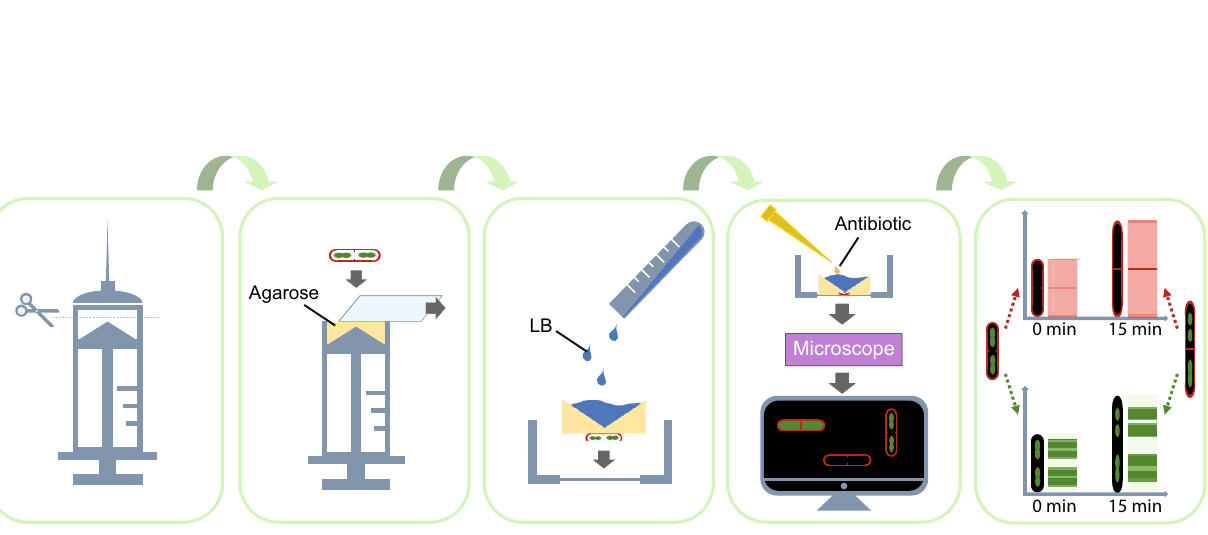
Figure 2. Workflow for time-lapse imaging of bacteria. A single well LB agarose pad was made using a trimmed syringe to immobilize bacterial cells on its surface. A glass slide was used to keep the agarose surface flat and smooth. Upon solidification of the agarose, the glass slide was removed and drops with bacterial cultures were added onto the surface. Once the drops were dry, the agarose pad with bacteria was transferred into a confocal dish for imaging. The thick agarose pad provided enough nutrition to sustain growing cells, allowing time-lapse imaging for hours, even overnight. Bacteria were imaged to verify that they were growing normally. Subsequently, the well on top of the agarose pad was used to administer antimicrobial solutions to bacteria at any stage of the imaging process. After imaging, raw micrographs were converted into dynamic patterns by quantifying the fluorescence intensities of the membrane and nucleoid staining separately along the length of the